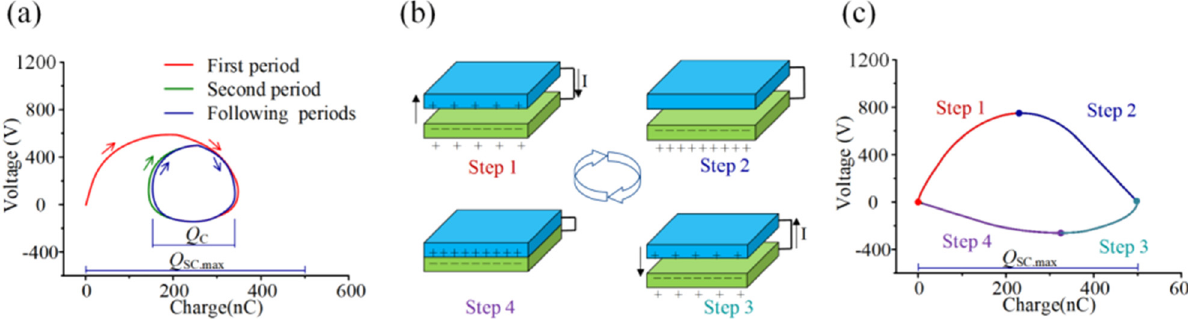
Figure 5: ( a ) Voltage – charge ( V – Q ) plot for CEO, ( b ) working process of TENGs, and ( c ) V – Q plot for CMEO [ 50